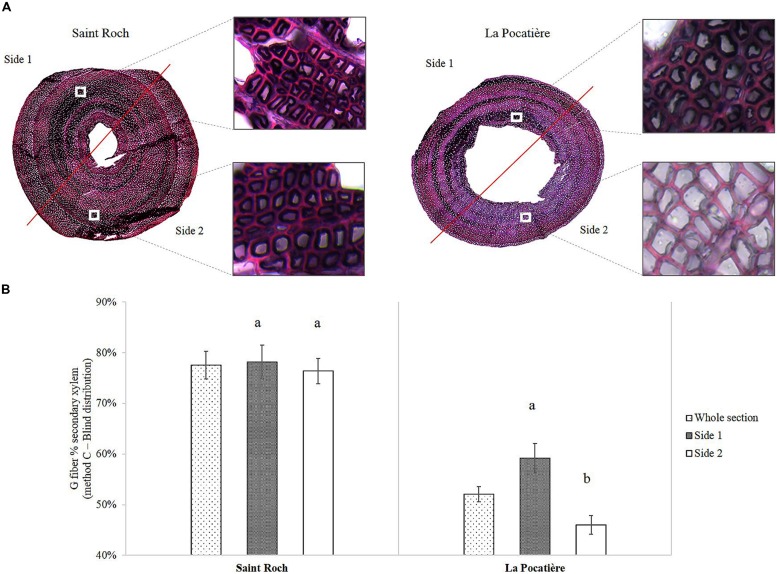
(A) 40 μm transverse section of a stem from SX64 cultivated at Saint-Roch de l′Achigan (left – most dense) and at LP (right – least dense). Stained in 1% Chlorazol Black E in methoxyethanol and 1% aqueous Safranin O. (B) Polarization of G fibers determined by Method C (Blind distribution) from SX64 cultivar (S. miyabeana) in its third year of a harvest cycle sampled at two field trials: Saint-Roch-de-l′Achigan and LP. Error bars represent standard error (n = 3 trees, one per randomized block). t-test pairwise post hoc test (α = 0.05) are represented by letters a–b.